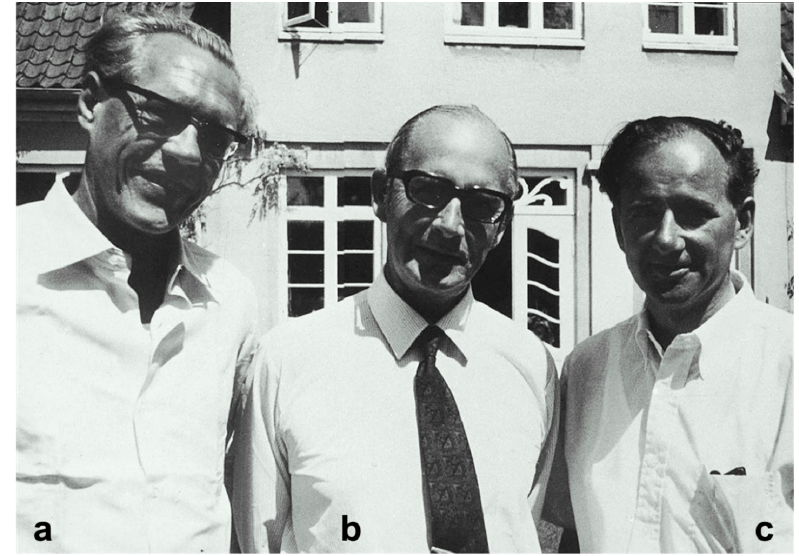
Figure 13. Three great pioneers of the clinical introduction of lithium: Poul Christia Baastrup ( a ), John Cade ( b ) and Mogens Schou ( c ).